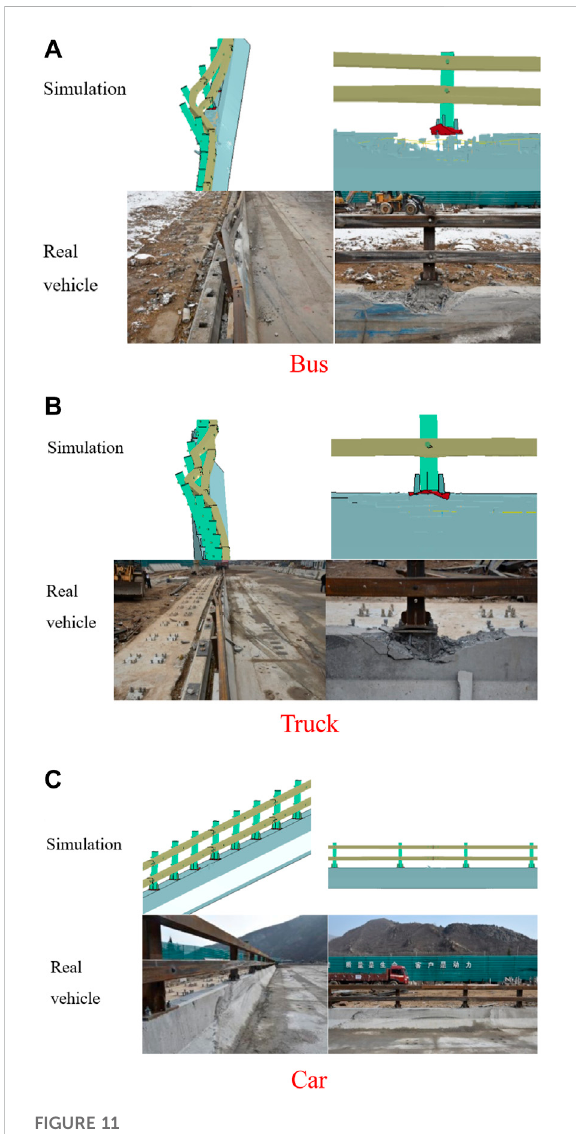
FIGURE 11 Comparison oftheguardraildamage byacrashtestand fi nite element